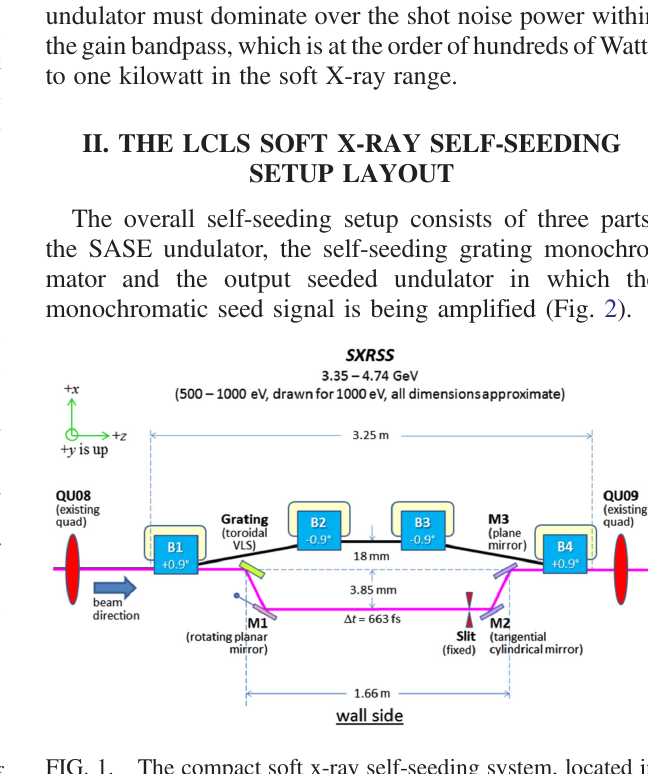
FIG. 1. The compact soft x-ray self-seeding system, located in U9. The grating is a toroidal VLS grating, M1 is a rotating plane mirror, M2 a tangential cylindrical mirror, and M3 a plane mirror used to steer the beam